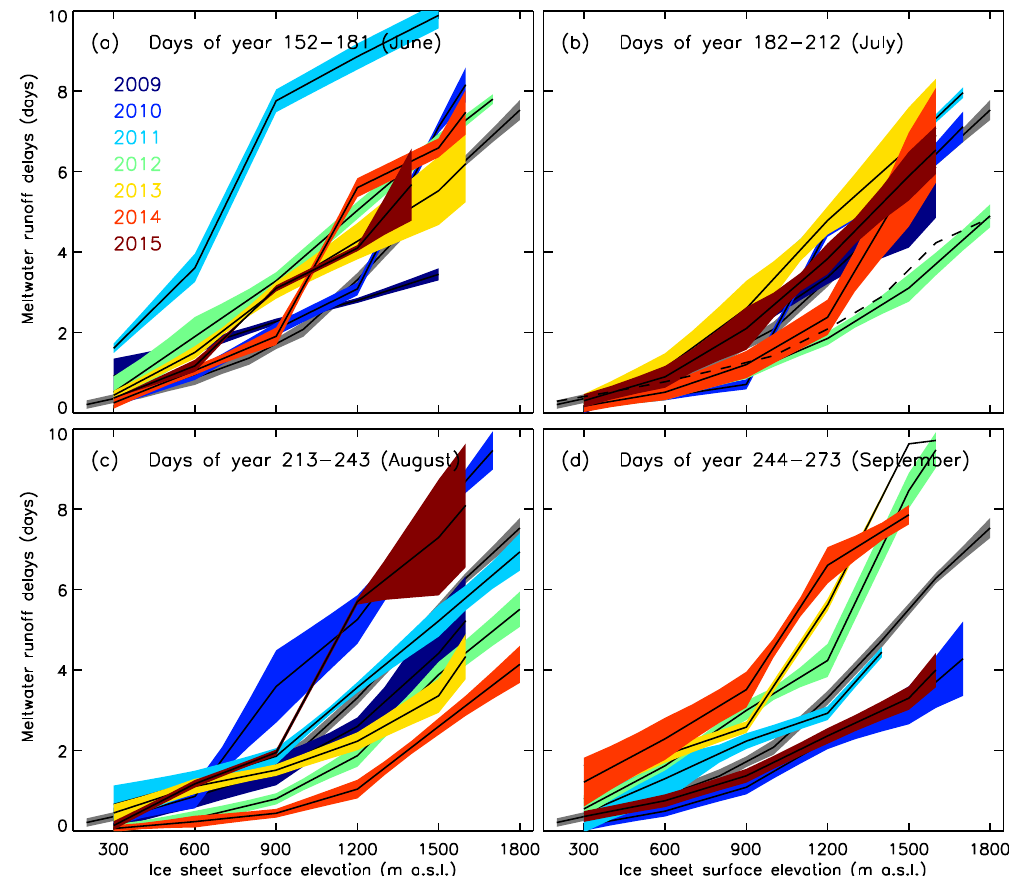
Figure 9. Optimal meltwater routing delays for the supra-, en-, sub-, and proglacial environments determined for June (a) , July (b) , August (c) and September (d) . As a reference, grey illustrates the values for the entire period with overlapping time series of river discharge and ice sheet surface meltwater runoff (June 2009–September 2015), as used for the red line in Fig. 7. The dashed line illustrates optimal routing delays for the 9–15 July 2012 period, encompassing the 10–14 July extreme discharge